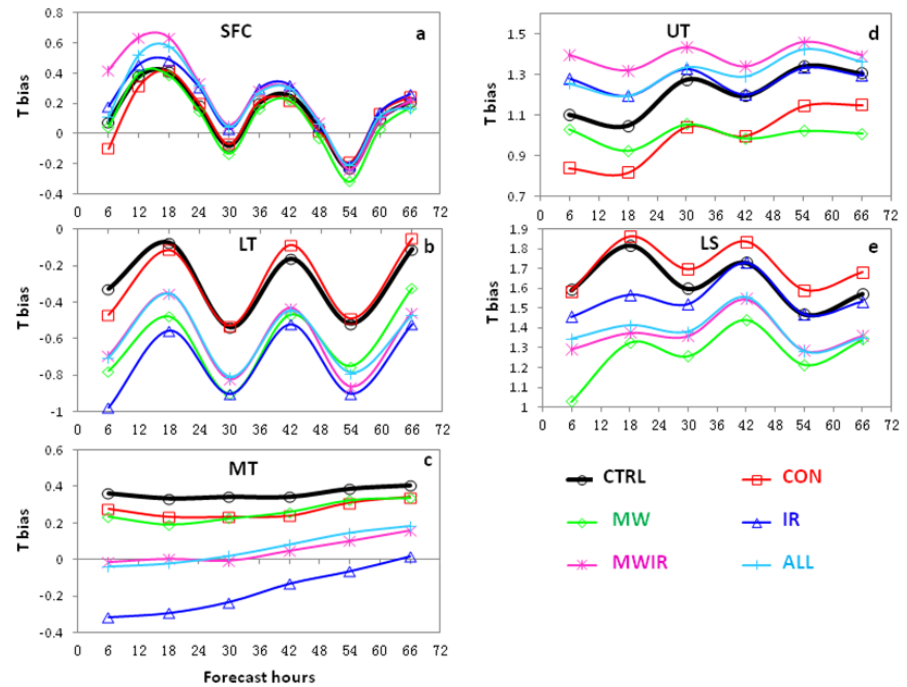
Figure 4. Bias of the temperature ( T ) forecasts at (a) surface (SFC), (b) lower troposphere (LT), (c) middle troposphere (MT), (d) upper troposphere (UT), (e) lower stratosphere (LS). Unit: ◦ C. CTRL , CON , MW, IR, MWIR and ALL are defined in Table